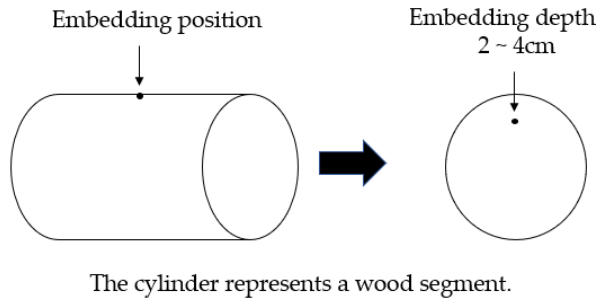
Figure 1. Acquisition equipment diagram.